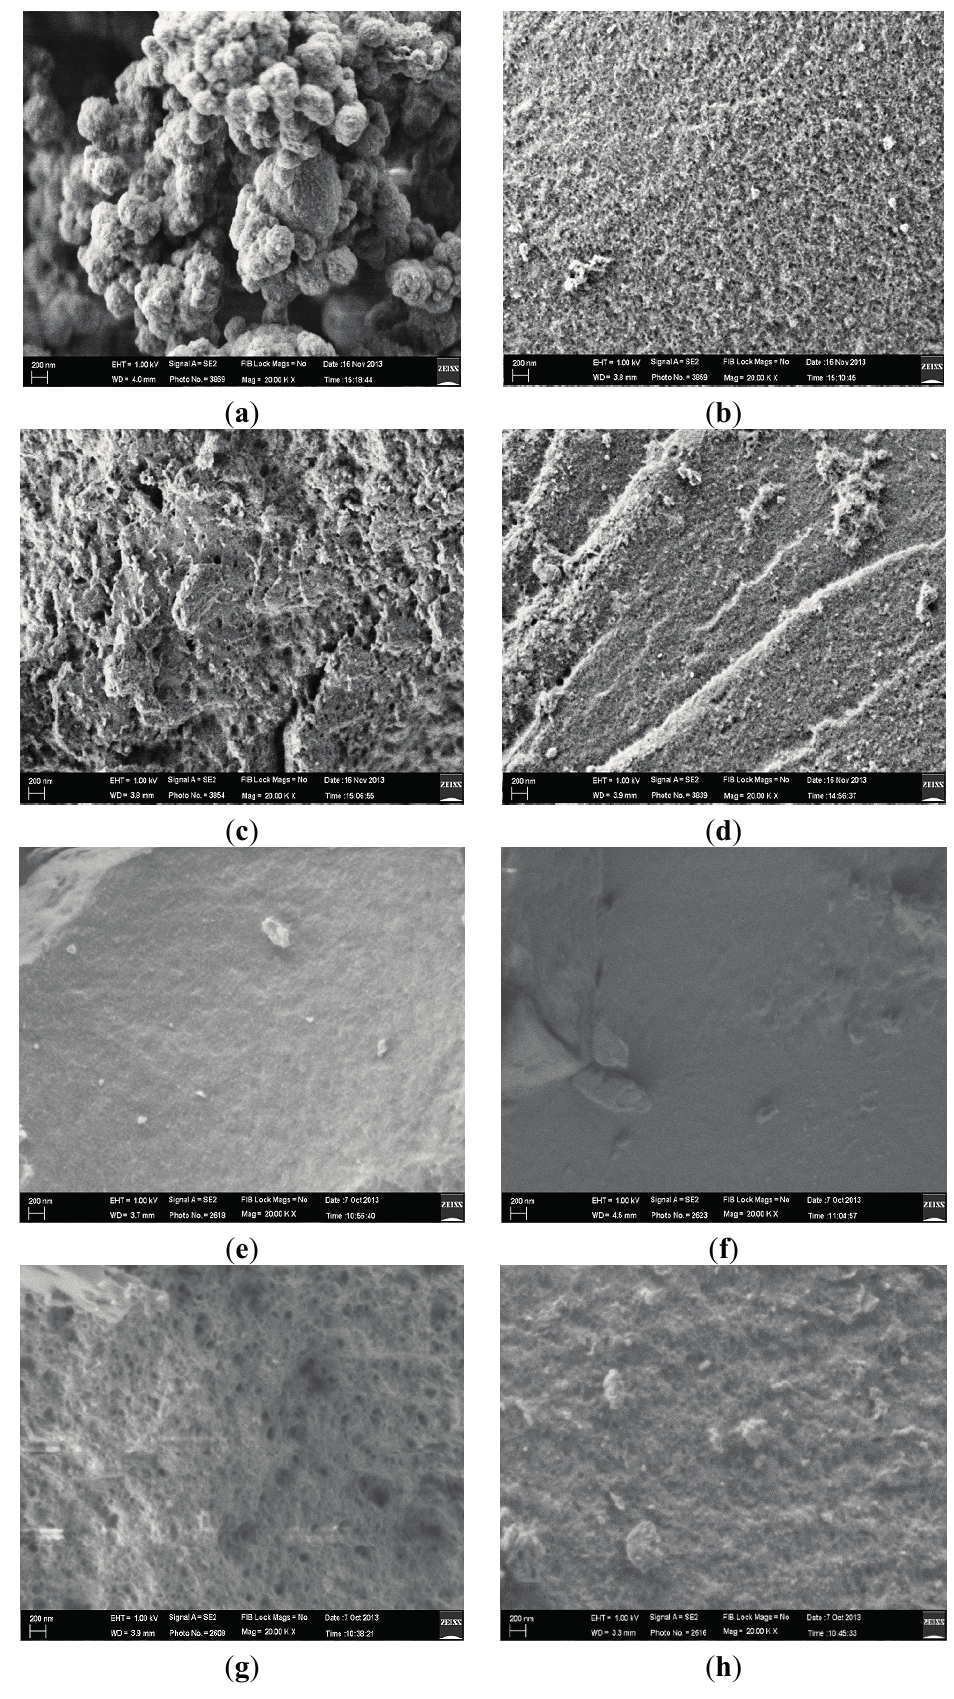
Figure 6. FESEM micrographs of ( a ) RAFT-MIP1; ( b ) RAFT-NIP1; ( c ) MIP1; ( d ) NIP1; ( e ) RAFT-MIP2; ( f ) RAFT-NIP2; ( g ) MIP2; and ( h )